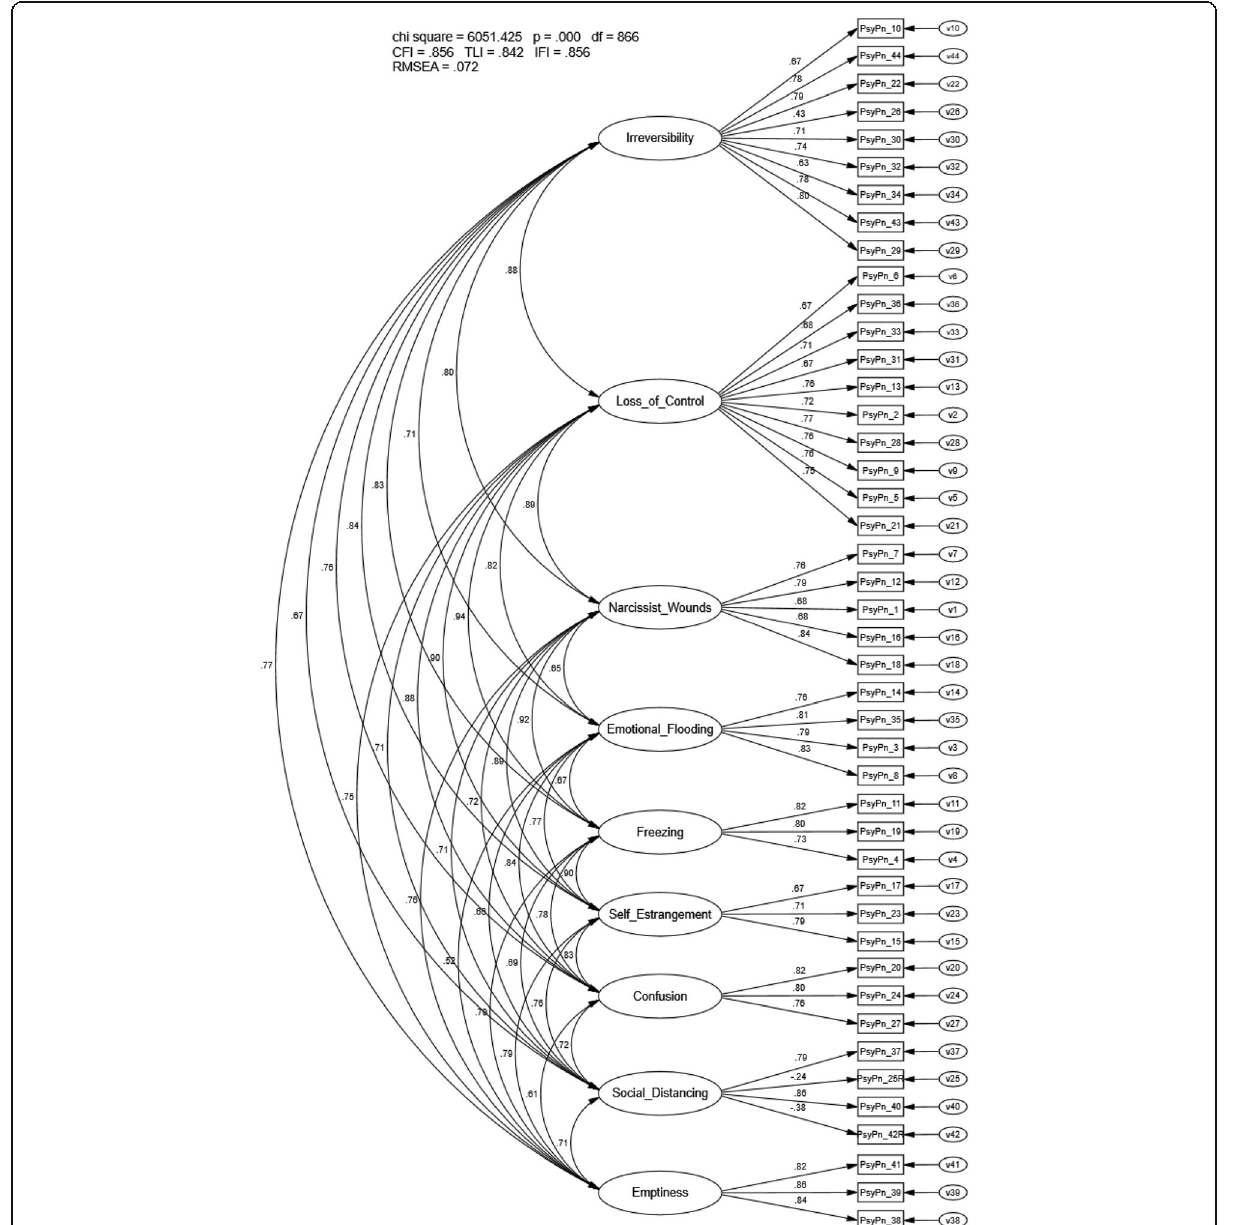
Fig. 1 Confirmatory factor analysis Orbach and Mikulincer Mental Pain